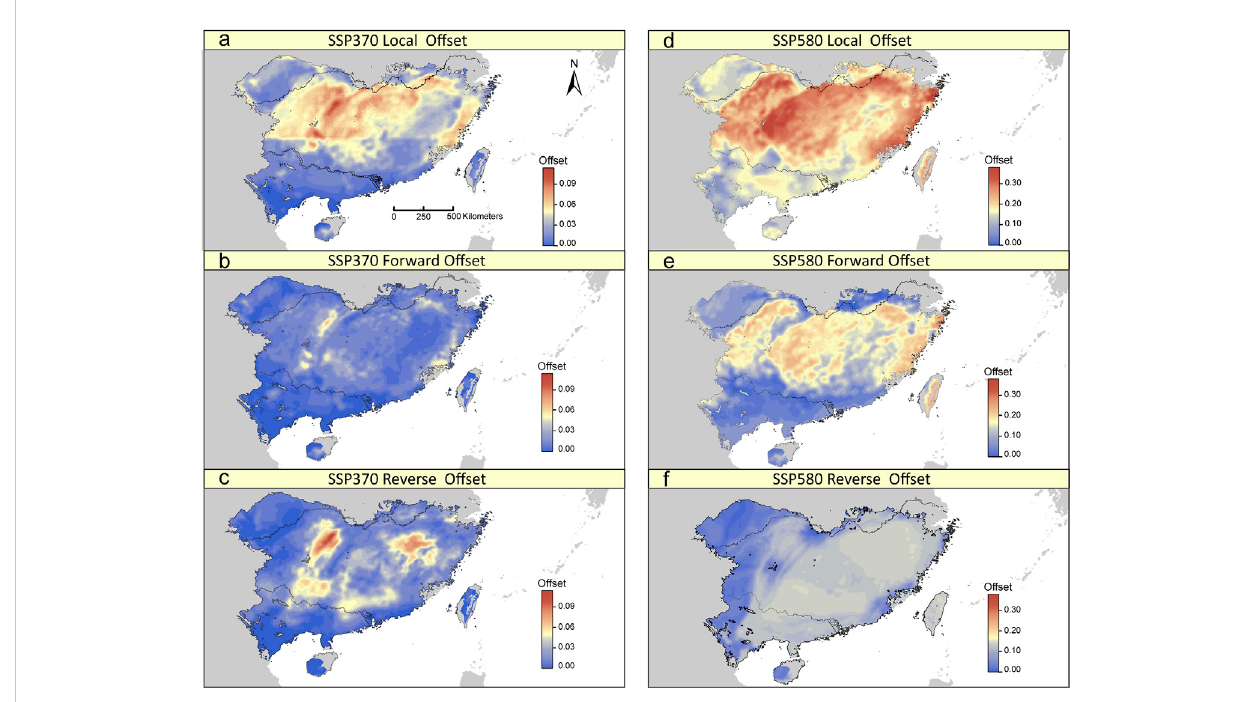
FIGURE 5 Spatial distribution of local, forward, and reverse genomic offsets estimated from GDM under SSP370 (A – C) and SSP580 (D – F) in 2070.